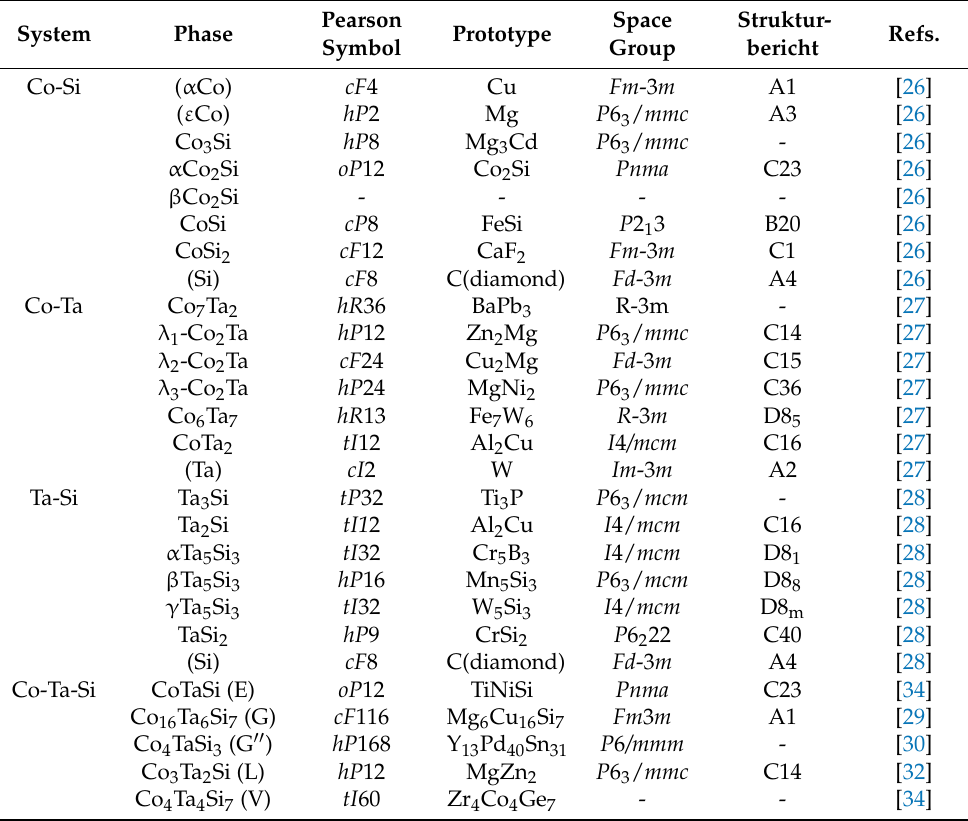
Table 1. The stable solid phases in the Co-Ta-Si ternary systems. System Phase